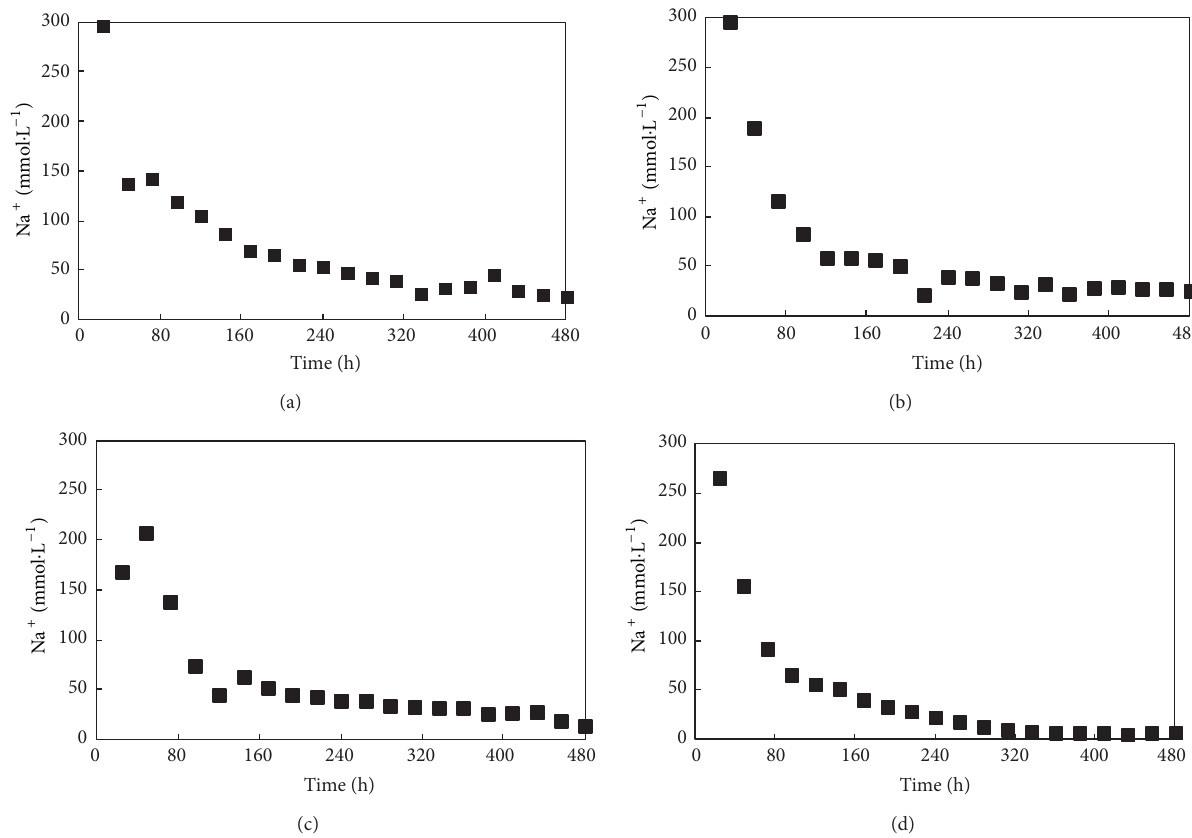
Figure 3: Change in the measured values of Na + in the leachate with leaching time ((a) T 1; (b) T 2; (c) T 3; (d) T 4). The explanation of each condition ( T 1– T 4) is reported in Table 2.